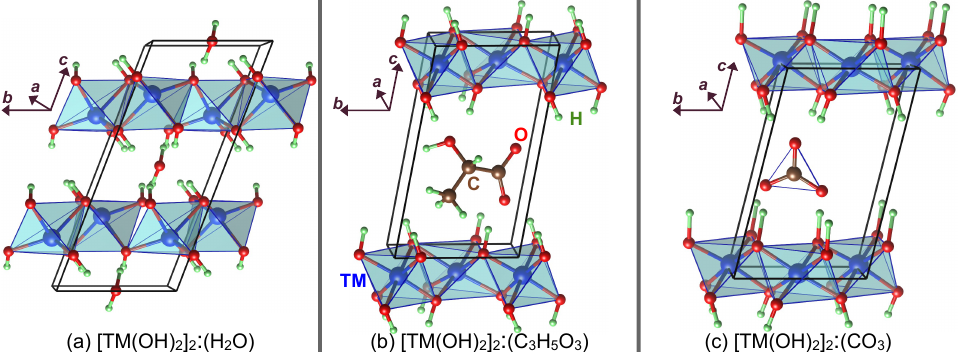
Figure 2. A representative of the LDH compounds intercalated with ( a ) H 2 O, ( b ) C 3 H 5 O 3 , and ( c ) CO 3 . The optimised structures had higher cantered monoclinic symmetry with group C 121 (group number 5) for the water intercalated compounds. The rest of the structures were P